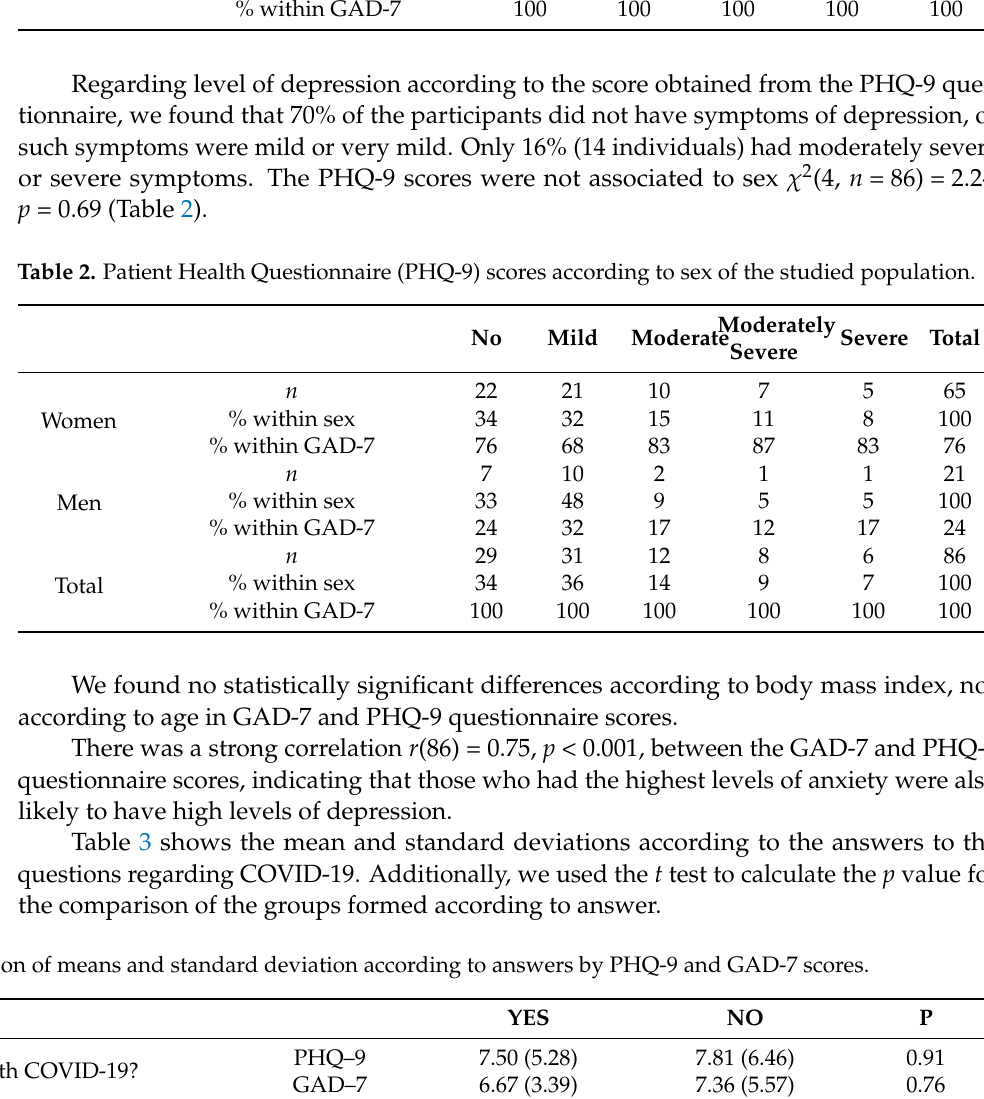
Table 3. Comparison of means and standard deviation according to answers by PHQ-9 and GAD-7 scores. Have you been ill with